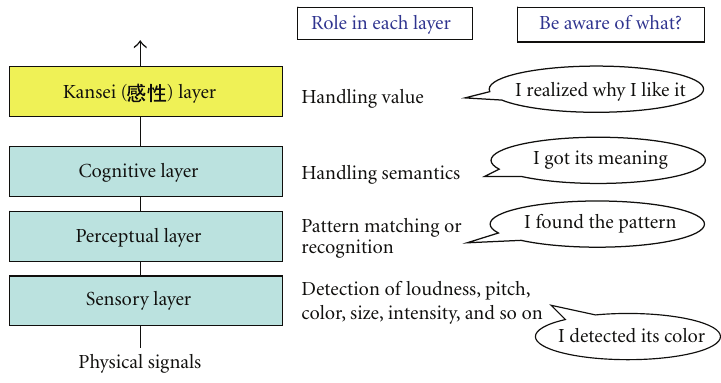
Figure 8: Awareness in di ff erent psychological